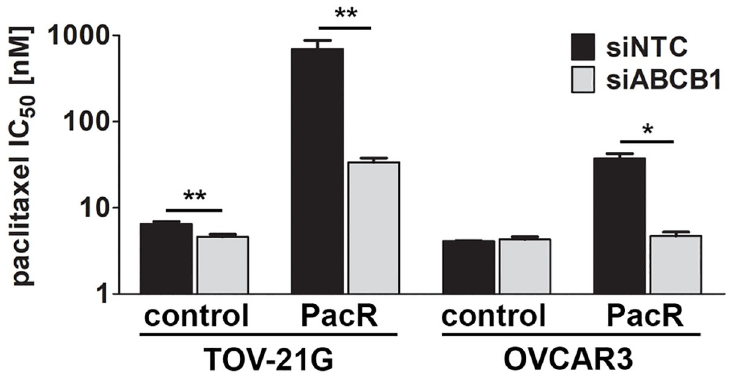
Fig 5. ABCB1 overexpression is sufficient for paclitaxel resistance in ovarian cancer. Cell viability following paclitaxel treatment was examined after silencing ABCB1 expression in TOV-21G and OVCAR3 cells. IC 50 values were compared across non-target siRNA (siNTC) and ABCB1 siRNA (siABCB1) transfected cells using unpaired two-tailed t-tests. � p < 0.05; �� p < 0.005.